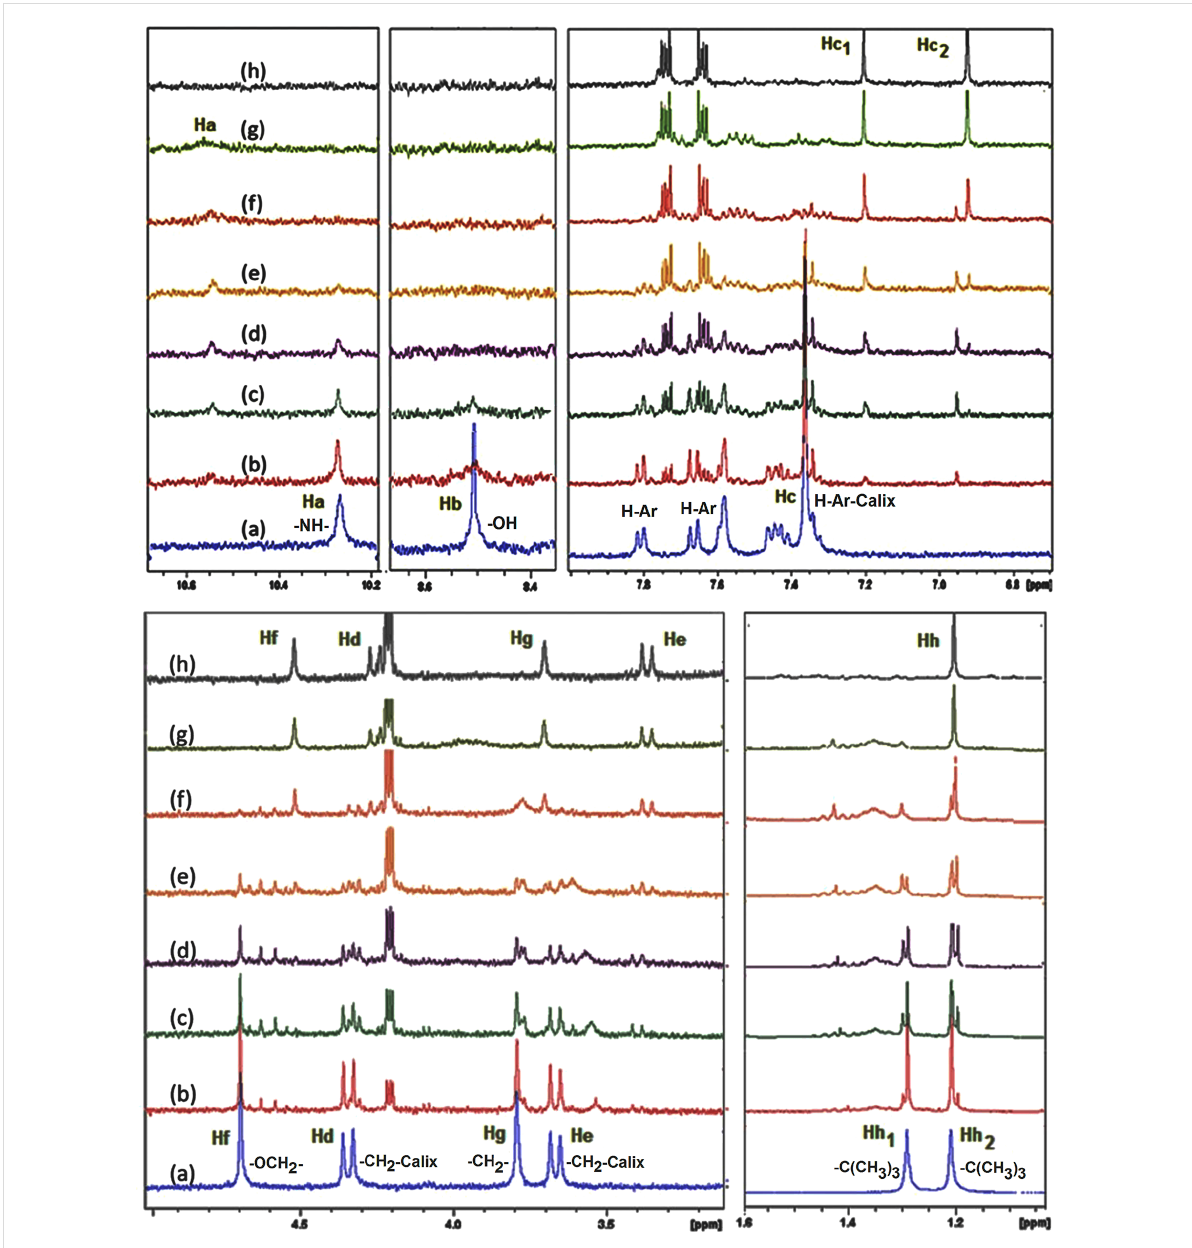
Figure 7: 1 H NMR (400 MHz, CD 3 CN) spectra of L upon addition of (a) 0.0 equiv, (b) 0.2 equiv, (c) 0.4 equiv, (d) 0.6 equiv, (e) 0.8 equiv, (f) 1.0 equiv, (g) 1.2 equiv and (h) 1.5 equiv of Cu 2+ .